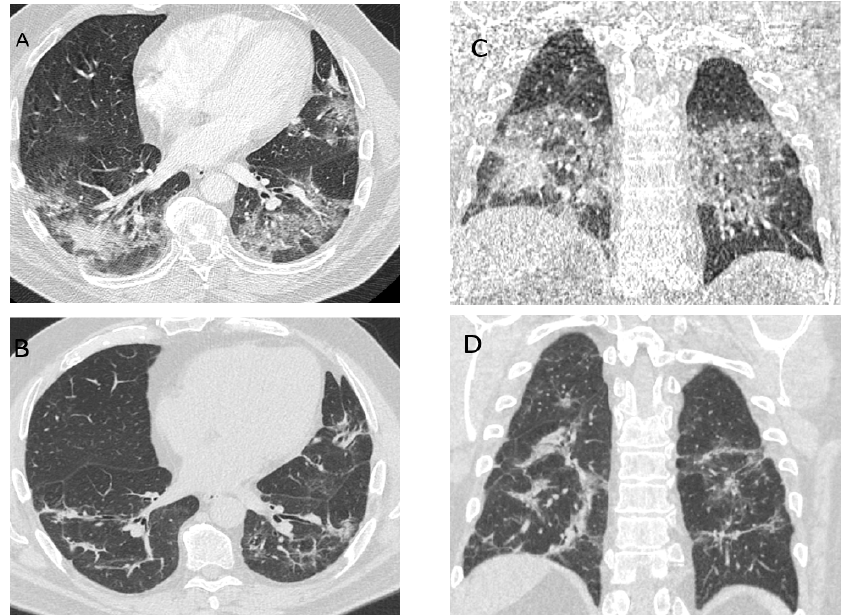
Figure 2. A 59-year-old man, with severe COVID-19 pneumonia treated in hospital. ( A , C ) At 10 days after the onset of symptoms. Peribronchovascular, perilobular consolidation and ground- glass opacities—organizing pneumonia and nonspecific interstitial pneumonia. ( B , D ) At 2 months after diagnosis with persistent respiratory symptoms; the patient was not treated with oral gluco- corticoids. Decreased areas of ground glass opacities, small consolidation with air bronchograms, fibrotic changes.